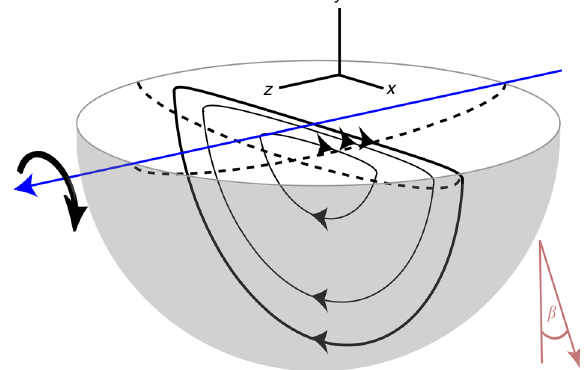
Fig. 1 Spherical tumbler geometry and fl ow. Sketch showing three representative particle trajectories (curves with arrowheads) in the fl owing layer and in solid body rotation in a plane normal to the free surface and perpendicular to the z -rotation axis. The two dashed curves show the lower boundary of the fl owing layer in planes normal to the free surface and parallel and perpendicular to the rotation